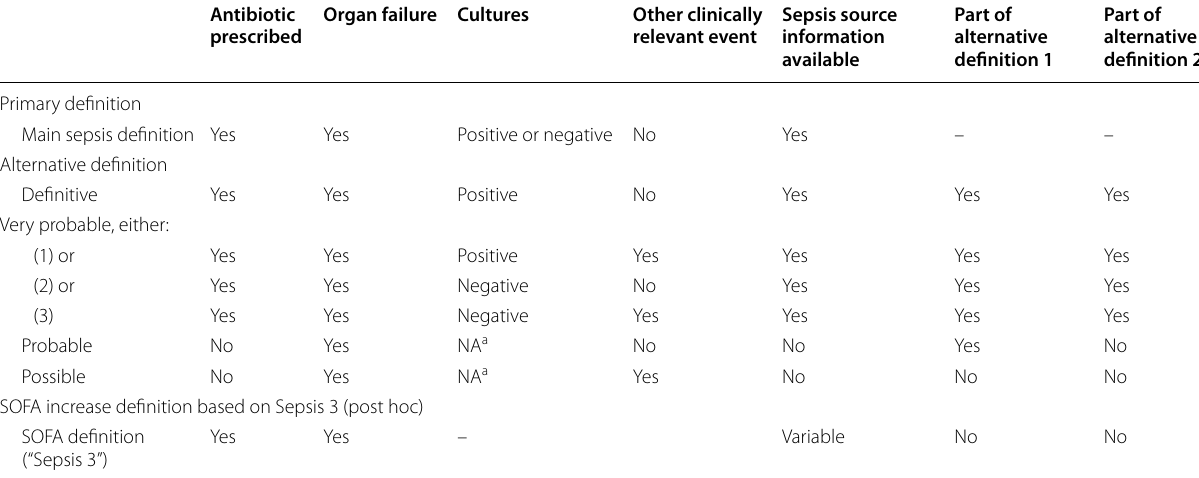
NA data not collected a Data on cultures were only collected for patients that received antibiotics. SOFA definition was performed post hoc. Any patients that had an increase in SOFA score of at least 2 points over baseline (hospital admission) SOFA and that either were started antibiotics or received new antibiotics were considered as